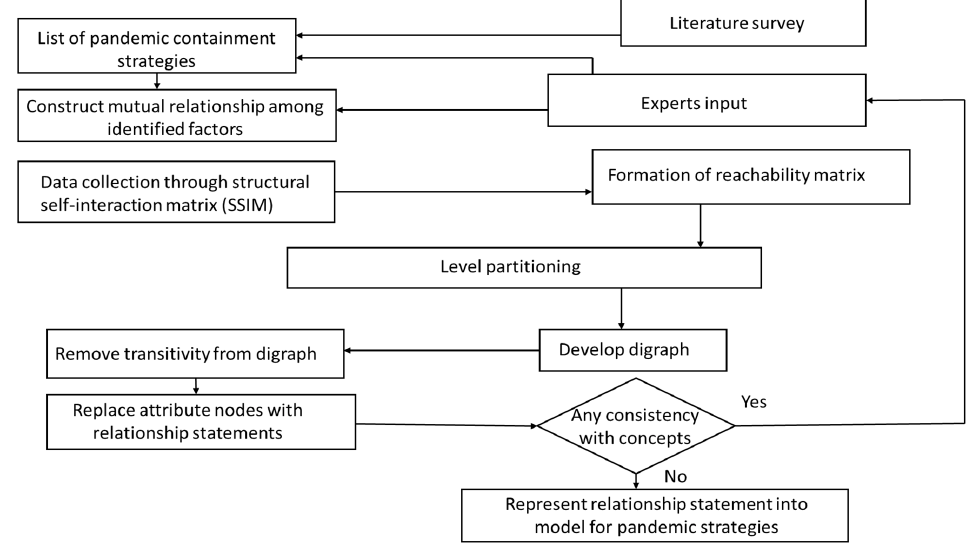
Figure 1. Step-by-step approach.